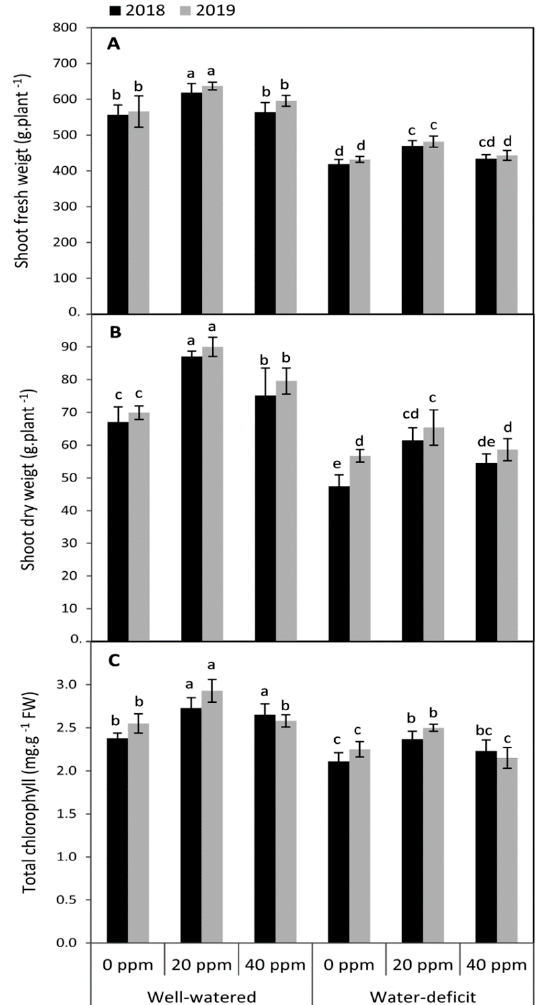
Figure 1. E ff ect of foliar application of melatonin (MT) at 0, 20 and 40 ppm on shoot fresh weight ( A ), shoot dry weight ( B ), and total chlorophyll ( C ) of tomato plants grown under well-watered and water deficit conditions in the seasons of 2018 and 2019. Means of three replicates were presented ± SD. Di ff erent letters are significant di ff erences, according to Duncan’s multiple range tests ( p <